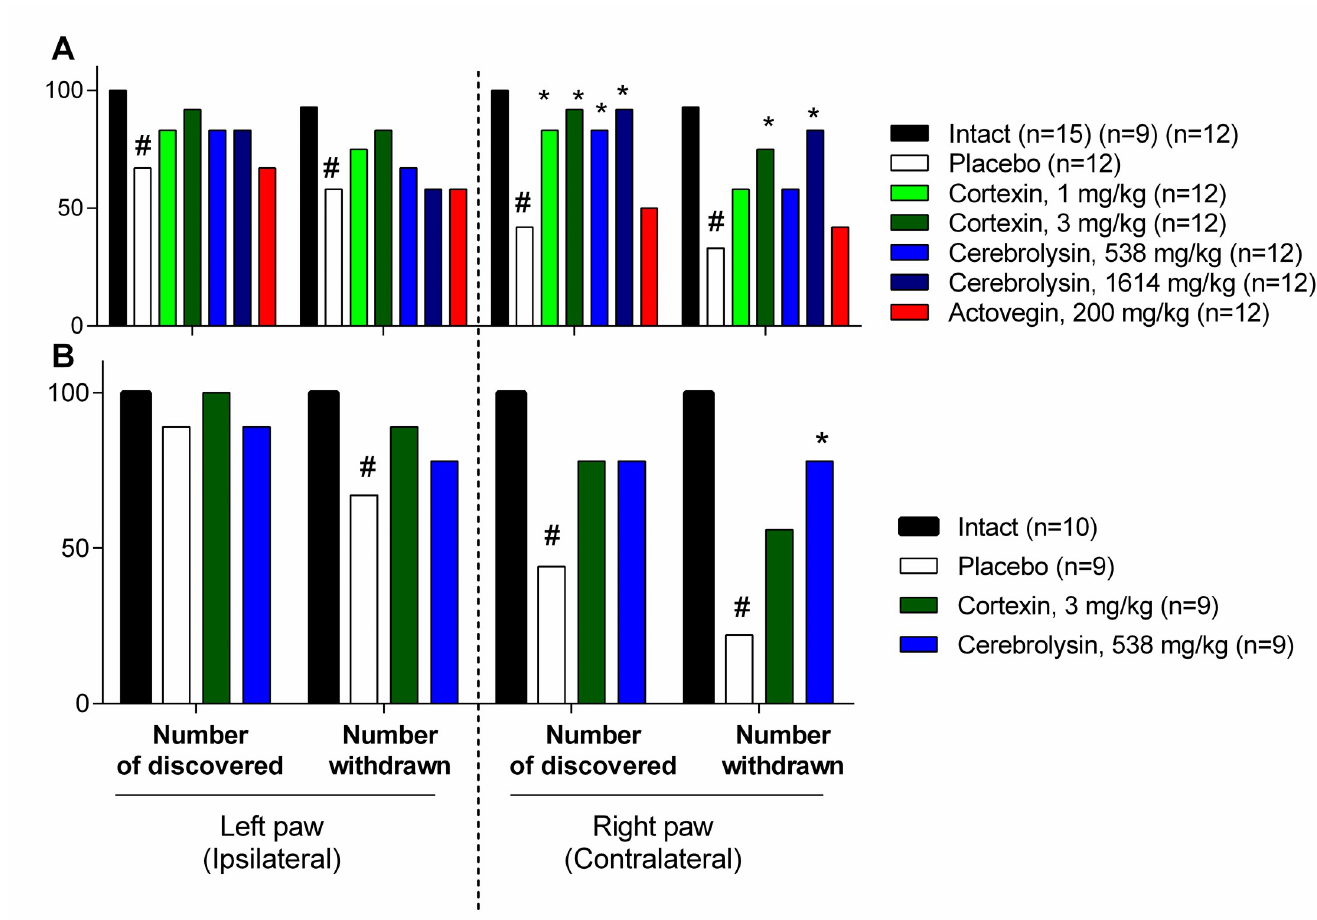
Fig 3. The number of animals that discovered and removed a foreign object during the adhesive tape test in 10- and 3-day follow-up experiments in acute brain ischemia model (A and B, correspondingly) (%). #–p < 0.05 compared to Intact; � –p < 0.05 compared to placebo group ( χ 2 test); data shown as the number of animals that discovered and removed the adhesive tape in the group (in